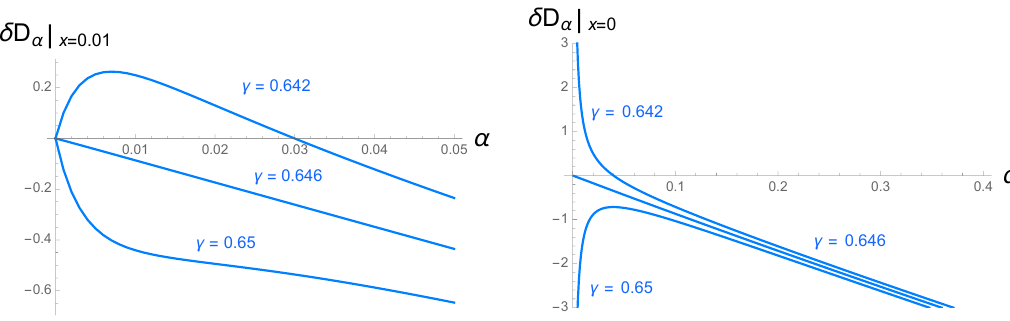
Figure 9 . The converse transition (cid:26) 2 ! (cid:26) 1 , here again with (cid:1) 1 = 0 : 9 and (cid:1) 2 = 0 : 6, is forbidden whenever (cid:14)D (cid:11) = D (cid:11) ( (cid:26) 1 k (cid:26) ) (cid:0) D (cid:11) ( (cid:26) 2 k (cid:26) ) is positive for some (cid:11) . (Left) The constraints are stronger R R for x < 1 and (cid:11) ! 0. (Right) The limiting case x = 0, which corresponds to R(cid:19)enyi entropies. We see R(cid:19)enyi’s with (cid:11) < 1 are more constraining than the von Neumann entropy. All of the